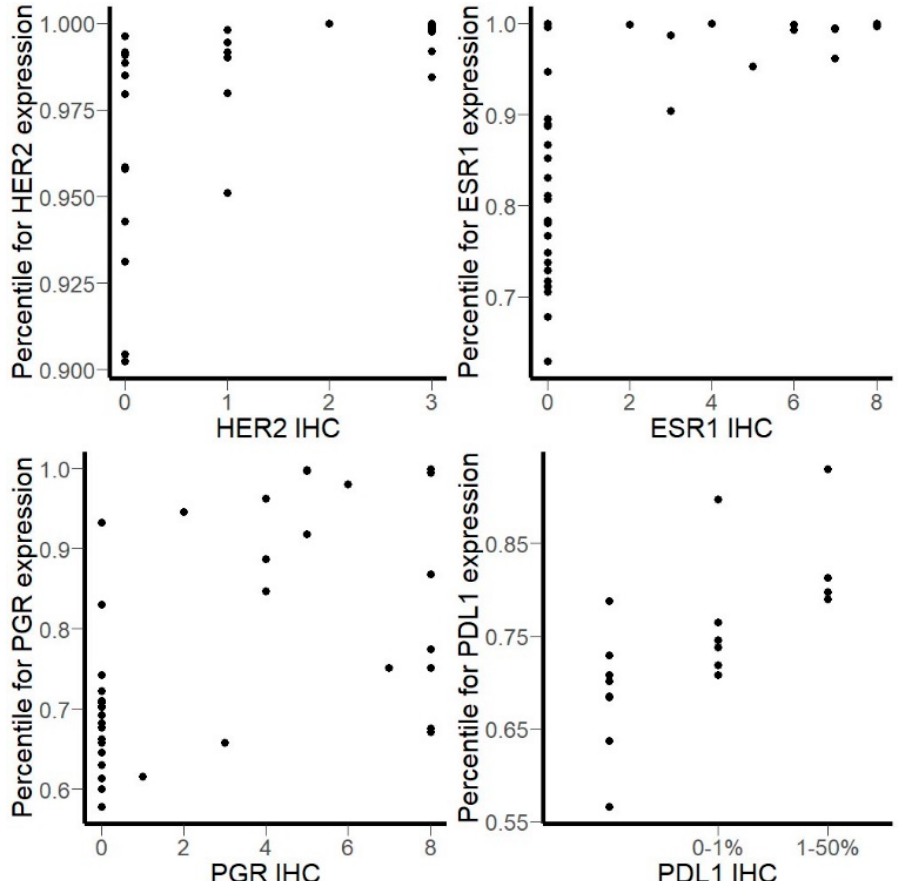
Figure 6. Percentile of gene counts for marker genes versus IHC (immunohistochemistry) score in breast and lung cancer samples.